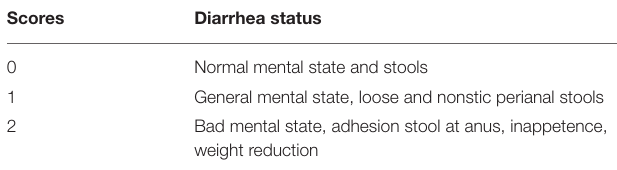
TABLE 1 | Diarrhea status scoring